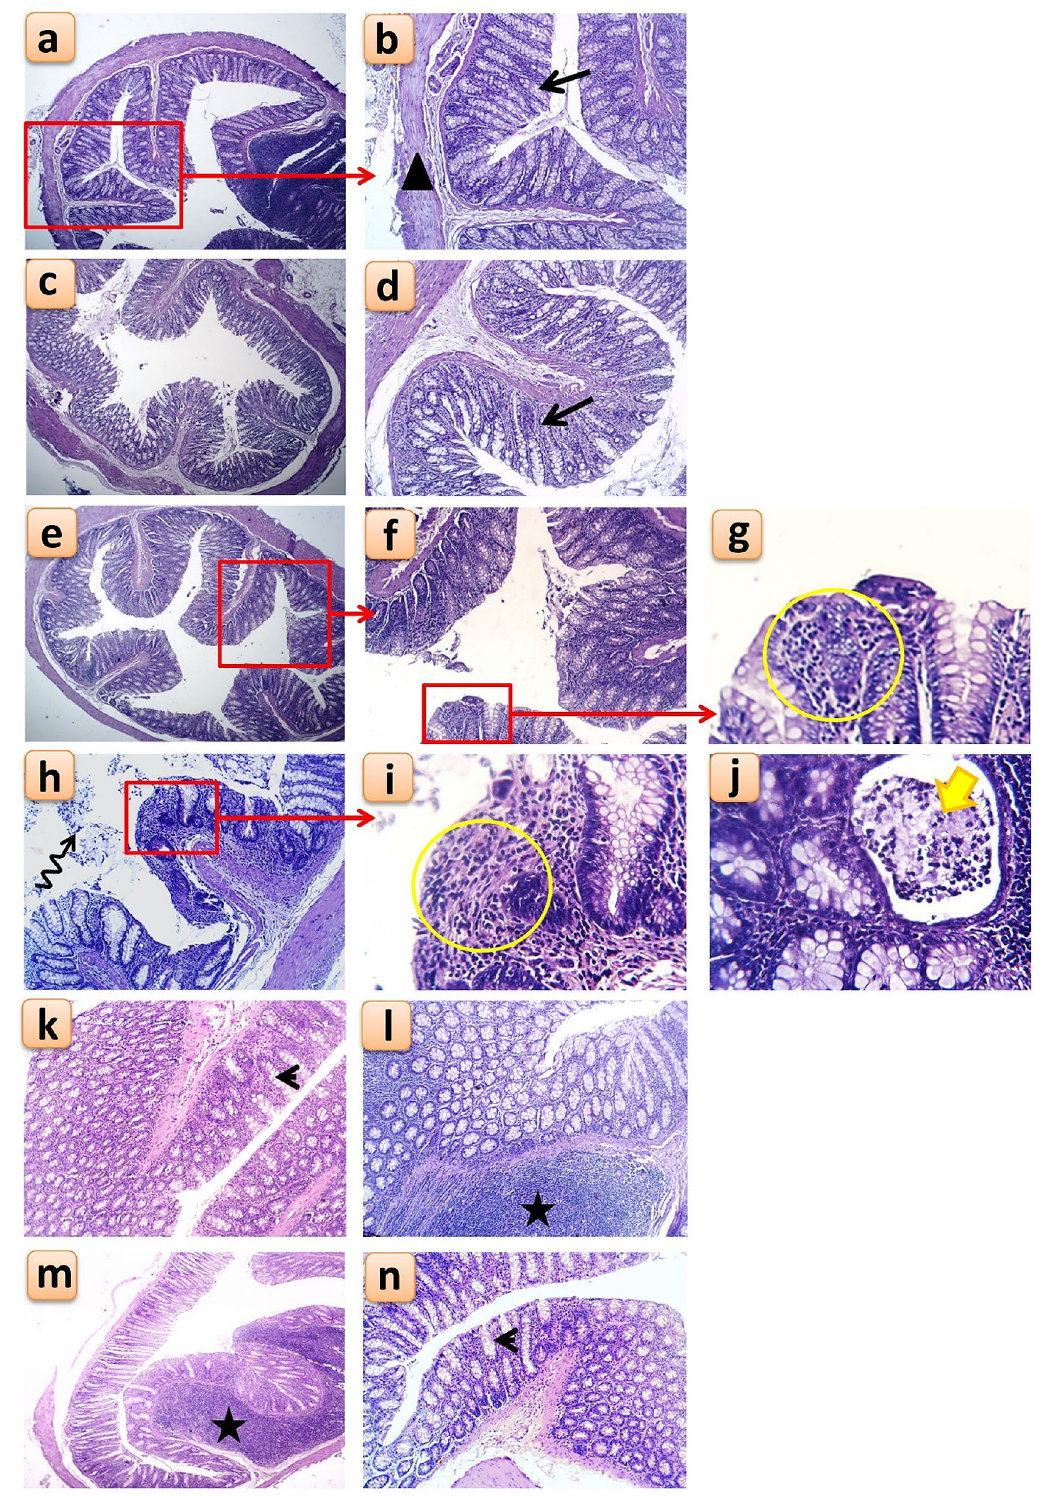
Figure 8. Histological changes following oral administration of B. amyloliquefaciens (BA) or BA-nanoparticles (BANPs) in non-colitic and colitic rats. Non-colitic groups including Control ( a , b ), BA ( c , d ) and BANPs ( e – g ) groups. While, colitic groups include DSS ( h , j ), DSS + BA ( k , l ) and DSS + BANPs ( m , n ) groups . Red rectangle = magnification of selected area, Arrow = normal colon crypt structure, black triangle = normal muscularis mucosa layer, yellow circle = diffuse leukocytic infiltration, zigzag arrow = desquamated colon epithelium, thick yellow arrow = mucosal abscess within the colonic crypts, arrow head = apparently normal colon crypts with increased number of goblet cells, star = prominent lymphoid aggregation within the